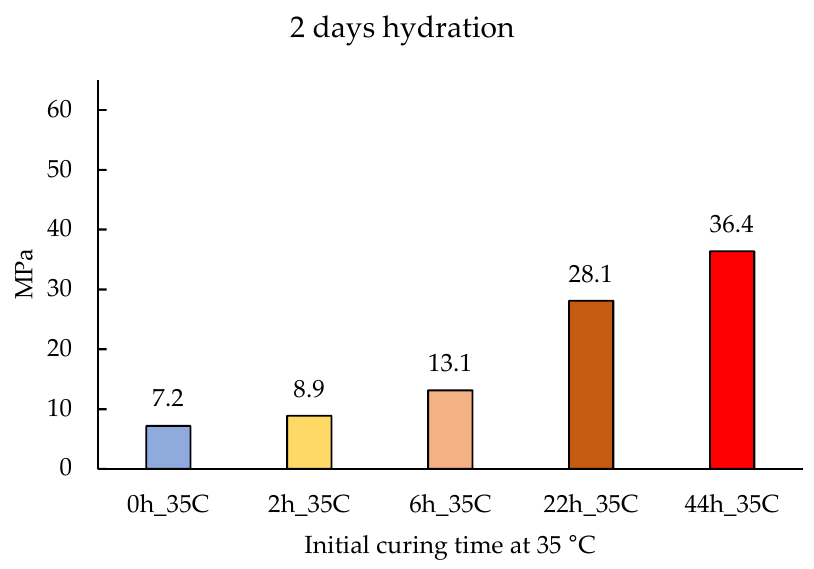
Figure 5. Compressive strength of alkali-activated mortars at 2 days of hydration. The curing times at 35 °C were 0 h, 2 h, 6 h, 22 h, and 44 h, followed by curing at 20 °C to complete the 2 days.